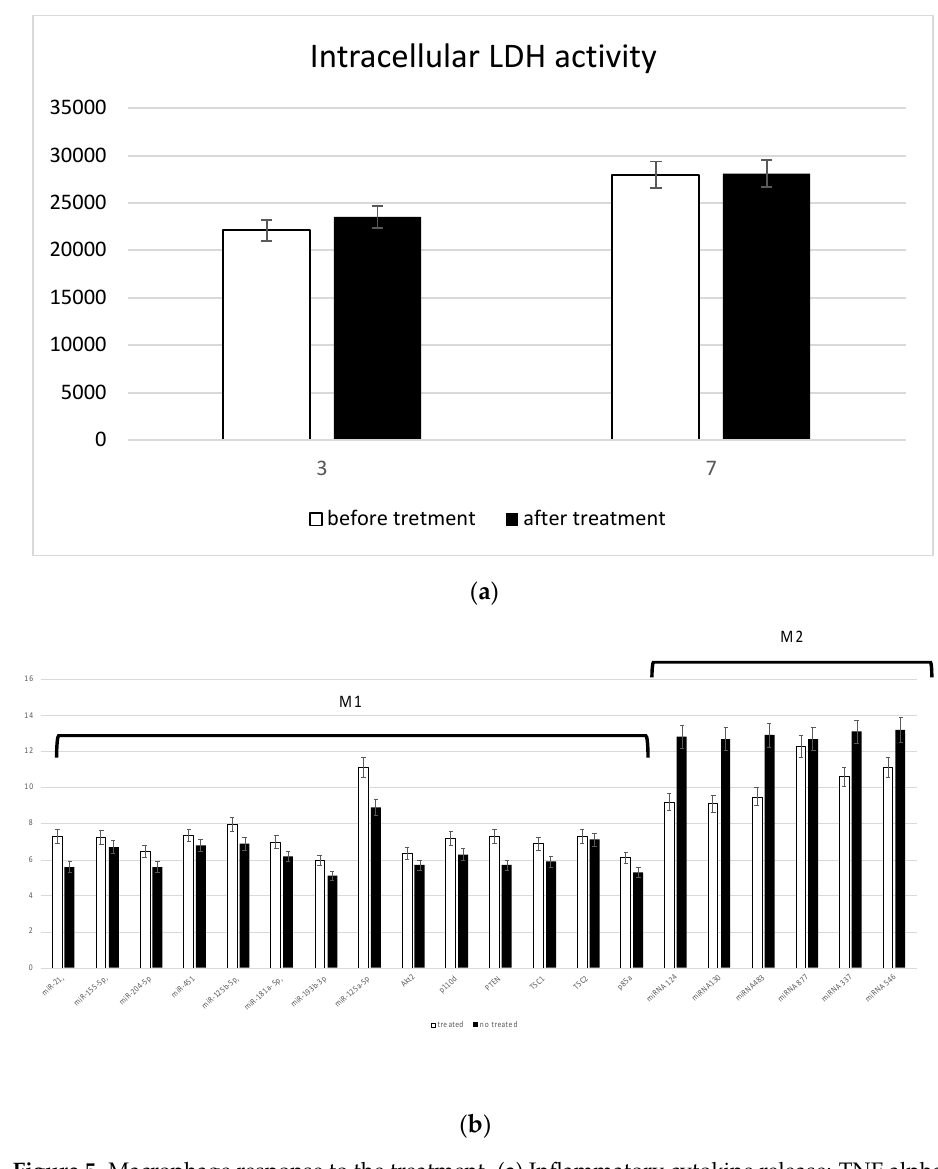
Figure 5. Macrophage response to the treatment. ( a ) Inflammatory cytokine release: TNF alpha, IL 1, and IL10. ( b ) Gene expression profile of M1 and M2 markers.